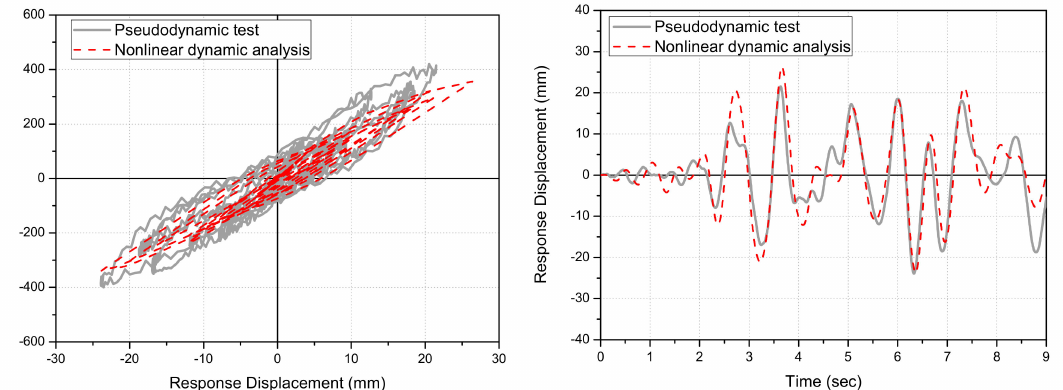
Figure 25. Comparison of seismic response load-displacement and displacement hysteresis loops during nonlinear dynamic analysis and pseudo-dynamic tests of the test frame retrofitted with NBSD-WSCS (first floor, 200 cm/s 2